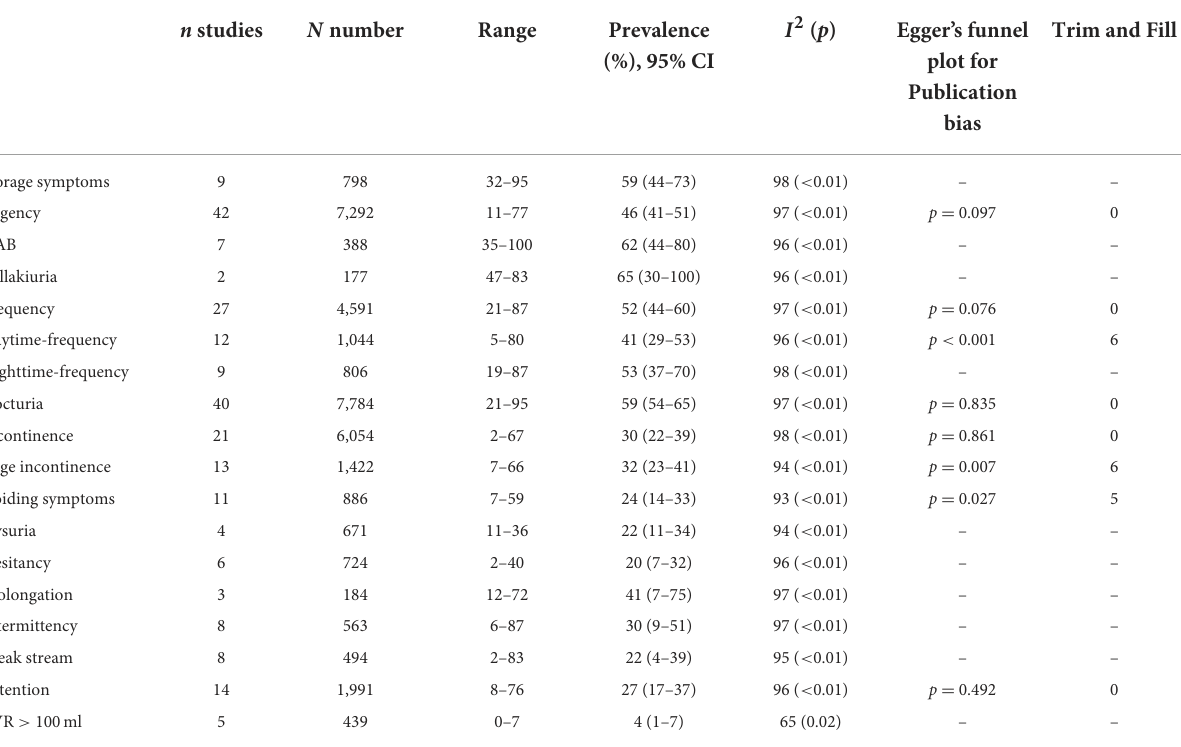
TABLE 3 Prevalence of LUTS subtypes in